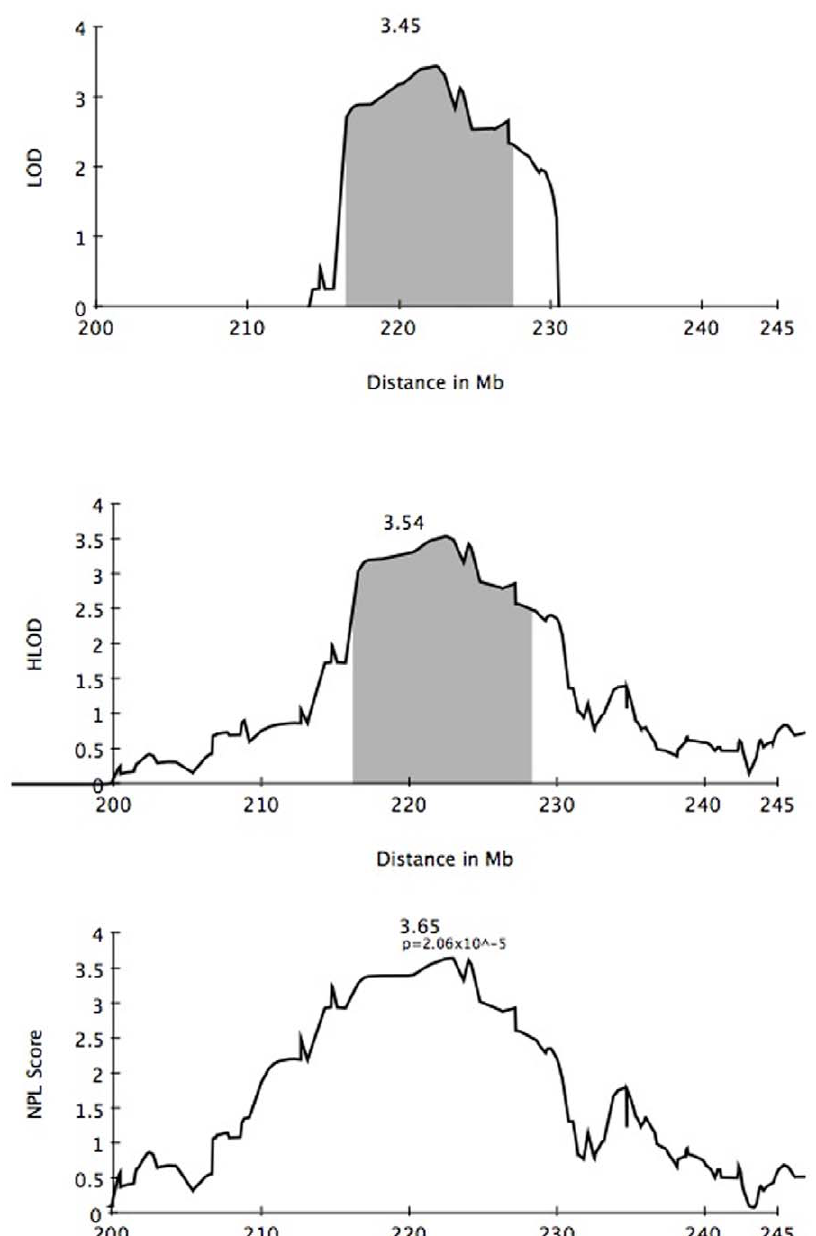
Figure 3. LOD, HLOD, and NPL scores for chromosome 1 in 17 families. The 1-LOD support interval around the maximum LOD of 3.45 is shaded in gray.